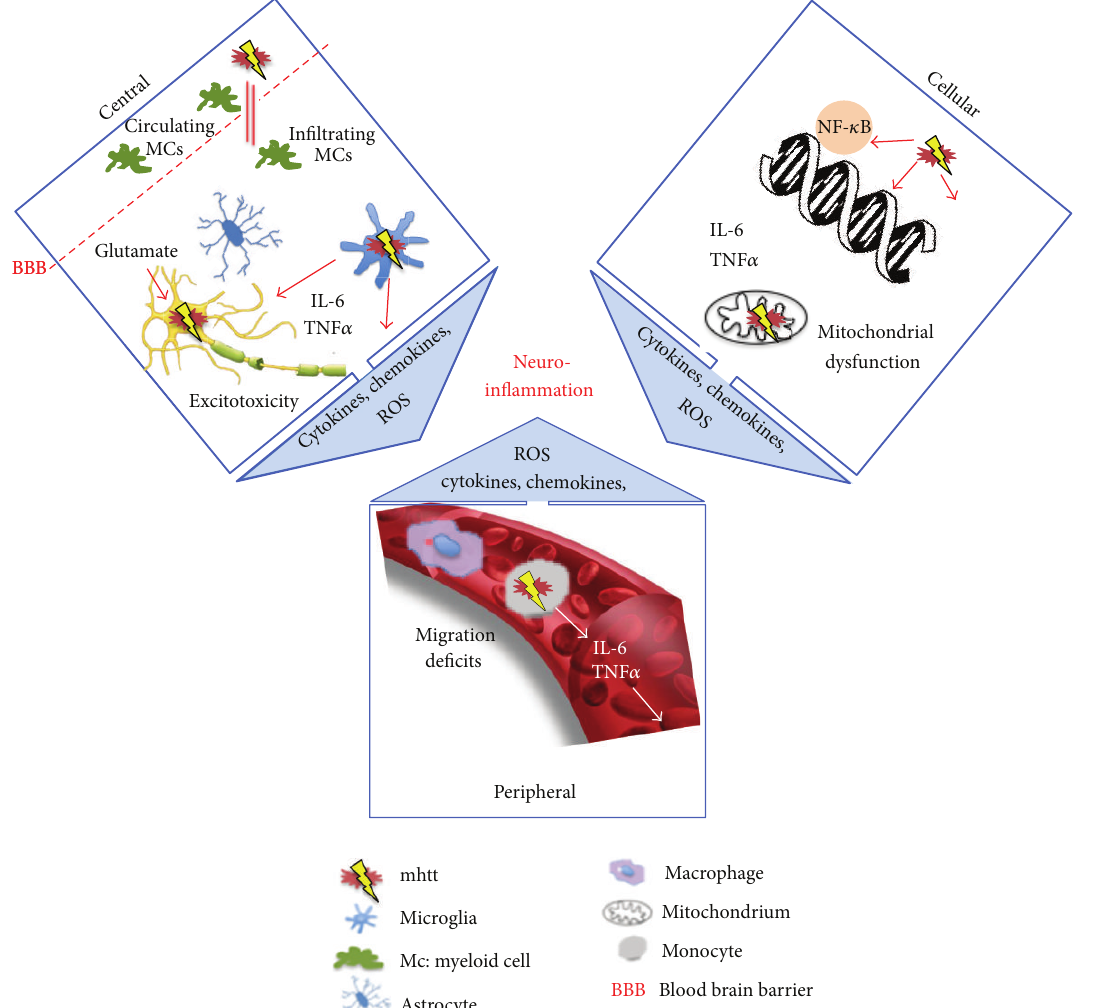
Figure 1: Neuroinflammation in the center of HD pathophysiology. Immune activation, induced by mutant huntingtin (mhtt), is found ubiquitously: in the central nervous system (central), the blood circulation (peripheral), and at molecular level (cellular). In the CNS, mhtt may not only influence migration of cells, for example, myeloid cells, but also induces microglia activation. Cytokines and chemokines (e.g., IL-6, TNF 𝛼 ) are secreted, and reactive oxygen species (ROS) are activated. Furthermore, glutamate-induced excitotoxicity, that is, in close interaction with oxidative stress, may contribute to degeneration. Migration deficits are discussed to influence innate immune response in the periphery very early in HD. Once again, cytokines, chemokines, and ROS in concert may trigger neuroinflammation. On a cellular level, mhtt upregulates the NF-kappa B (NF- 𝜅 B) signaling pathway that triggers IL-6 expression. Finally, mitochondrial dysfunction generated by mhtt seems to be a key player leading to neuroinflammation in HD. The complement system is a connection between the innate and adaptive immune response. There are two ways that activate the complement system: first, inflammation with all its resulting effects targets factors of the complement system. Second, antibody response and T-cell response follow in secretion of complement factors. Various cell types may be affected, among these monocytes, astrocytes, and T and B